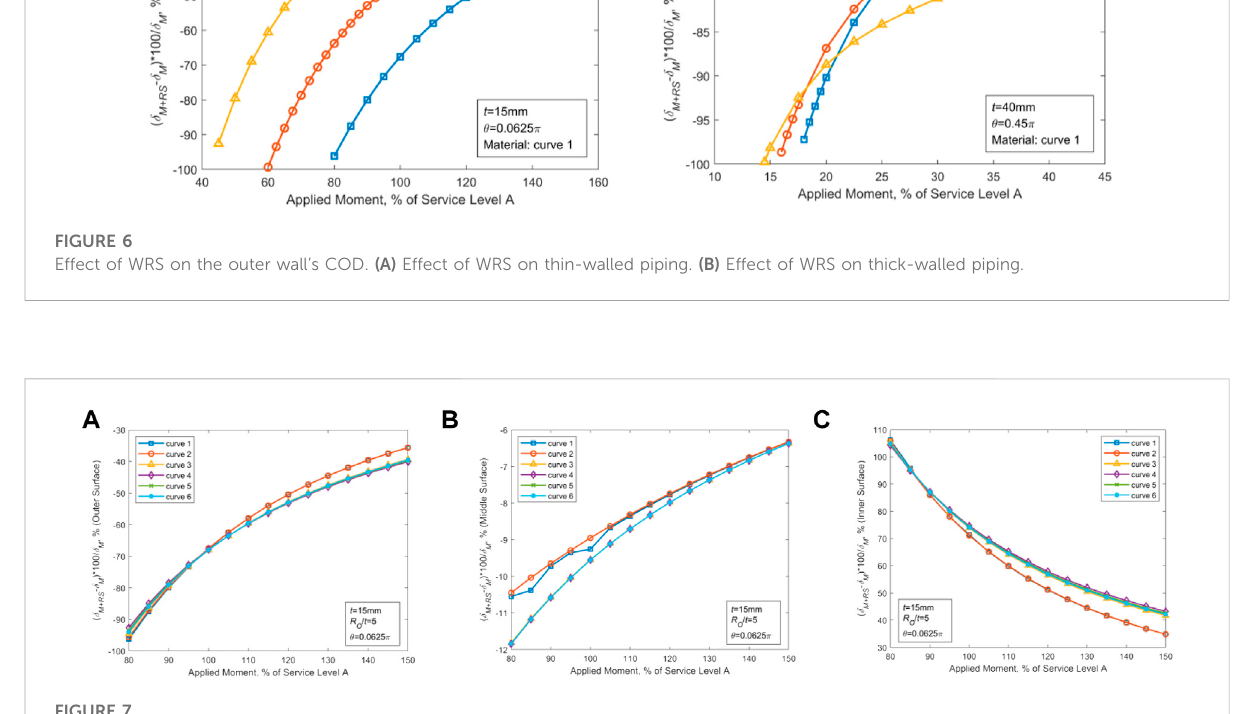
FIGURE 7 Effect of WRS on COD in various positions of the thin-walled piping with different material properties. (A) Changes in COD at the outer wall points (B) Changes in COD at the midpoints. (C) Changes in COD at the inner wall points.